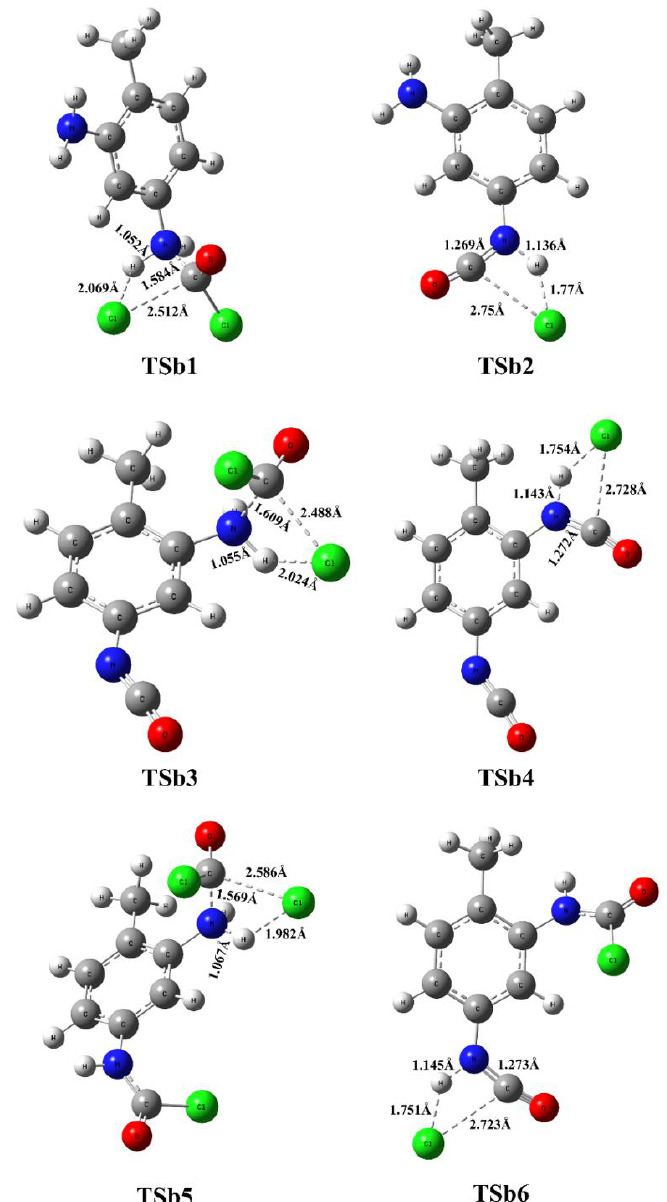
Figure 6. Transition state structures for the phosgenation of 2,4-TDA in gas phase.